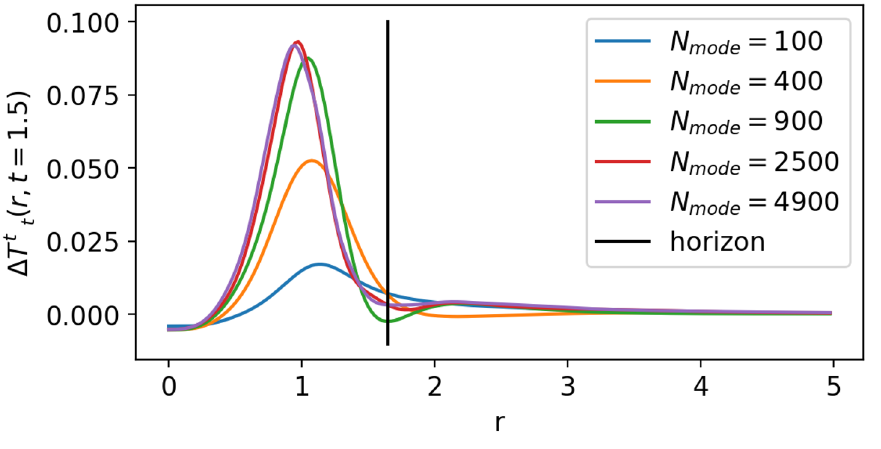
Figure 7 . Convergence study of quantum corrections for the stress-energy tensor component ∆ T t t = h χ | ˆ T t t | χ i − T t ct (with T t ct from the classical collapse) at t = 1 . 5